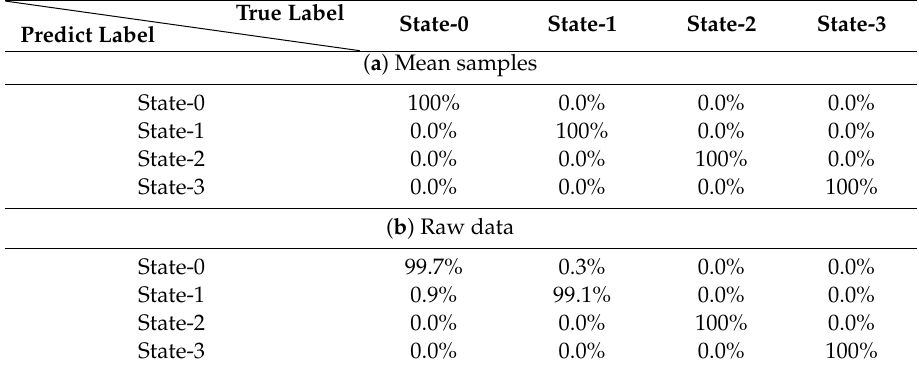
Table 3. Classification matching matrix with di ff erent input